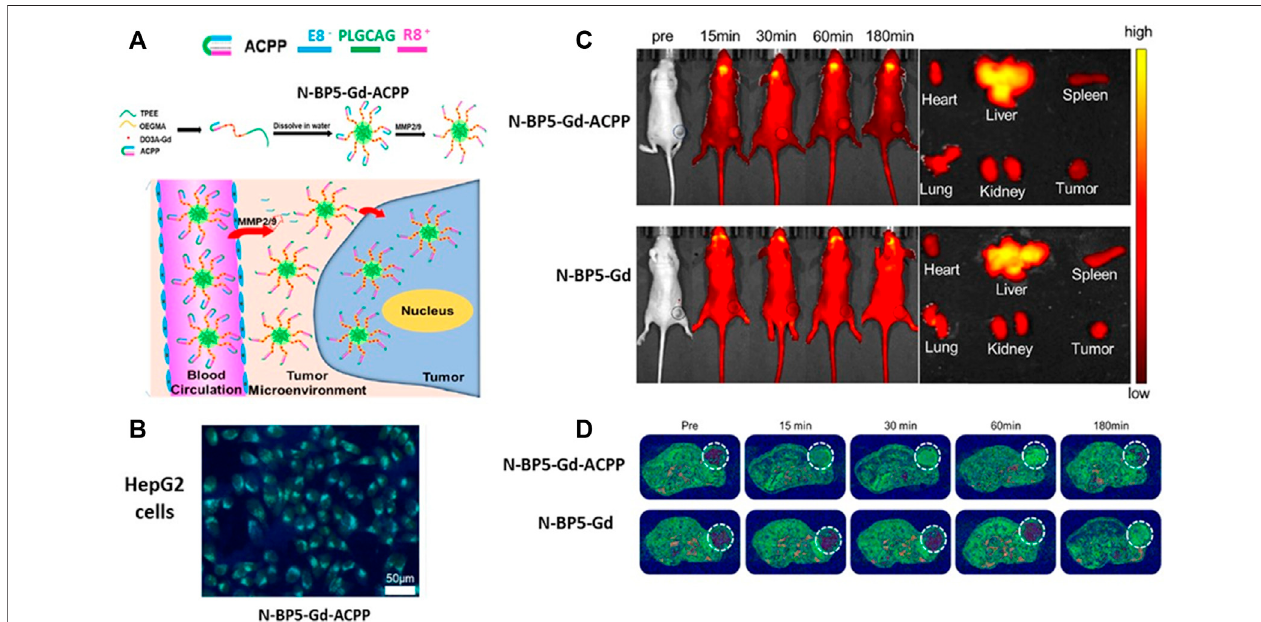
FIGURE 5 | MMPs ’ sensible peptides in imaging techniques. (A) MMP cleavable peptide included in an activable cell-penetrating peptide (ACPP) was integrated into the N-BP5-Gd-ACPP nanoprobe favoring its cell uptake. (B) Fluorescence image of hepatocellular carcinoma HepG2 cells incubated with N-BP5-Gd-ACPP. Incubations with N-BP5-Gd were not visible under the fl uorescence microscope (not shown in the fi gure) (C) Fluorescence images show the differences between HepG2 tumor-bearing animals injected with N-BP5-Gd-ACPP or N-BP5-Gd. (D) MR images demonstrate the rapid distribution of the N-BP5-Gd-ACPP nanoprobe in the tumors compared to animals injected with N-BP5-Gd. Adapted with permission from Xia, B., Yan, X., Fang, W.W., Chen, S., Jiang, Z., Wang, J., et al. (2020). Activatable Cell-Penetrating Peptide Conjugated Polymeric Nanoparticles with Gd-Chelation and Aggregation-Induced Emission for Bimodal MR and Fluorescence Imaging of Tumors. ACS Appl. Bio. Mater 3, 1394 – 1405. doi: 10.1021/acsabm.9b01049. Copyright 2020 American Chemical Society. Abbreviations: MMP, matrix